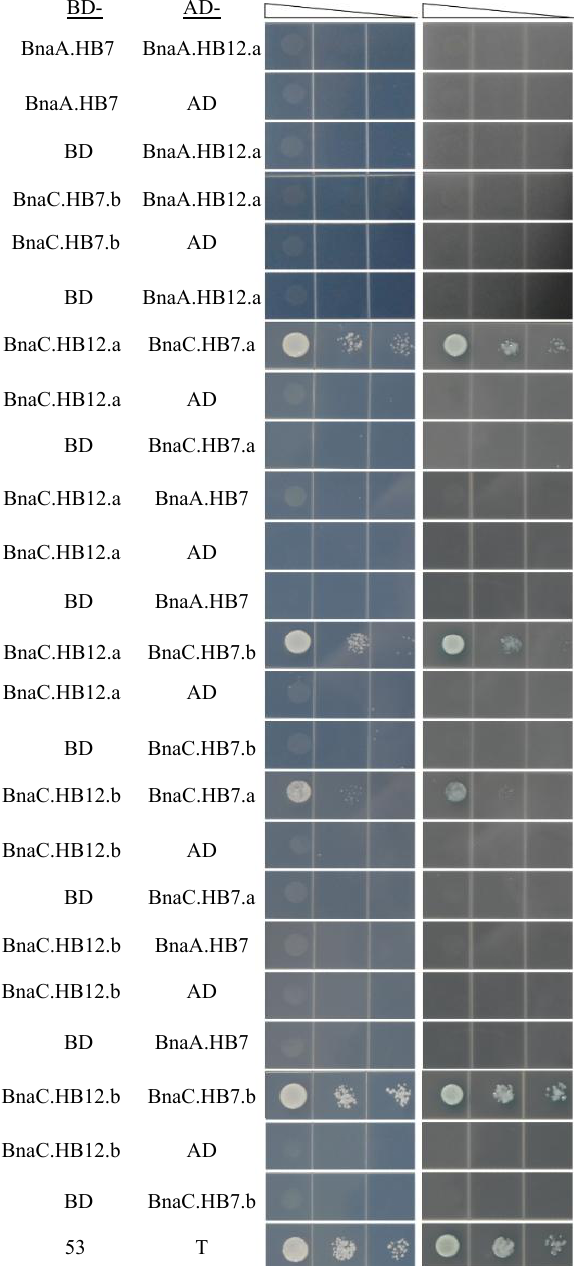
Figure 9. Results of the protein–protein interaction assay between BnHB7 and BnHB12 homologs by a yeast two-hybrid assay. Positive control: pGBKT7-53 as prey and pGADT7-T as bait. BnaC.HB12.a, similarly to BnaC.HB12.b, could form heterodimers with any BnaC.HB7.a and BnaC.HB7.b in